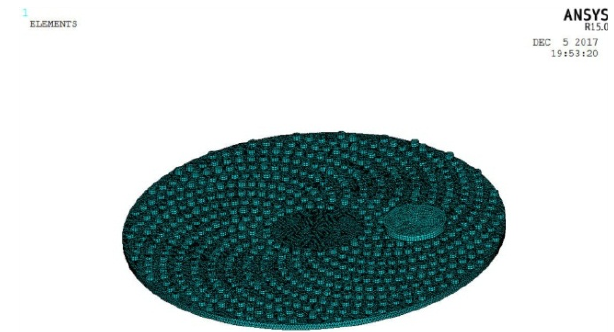
Figure 1. Contact mechanical model of the wafer and the surface of the fixed abrasive pad (FAP). Figure 2. Meshing diagram of the pad and the workpiece. Table 1. Material parameters of workpiece and pressure